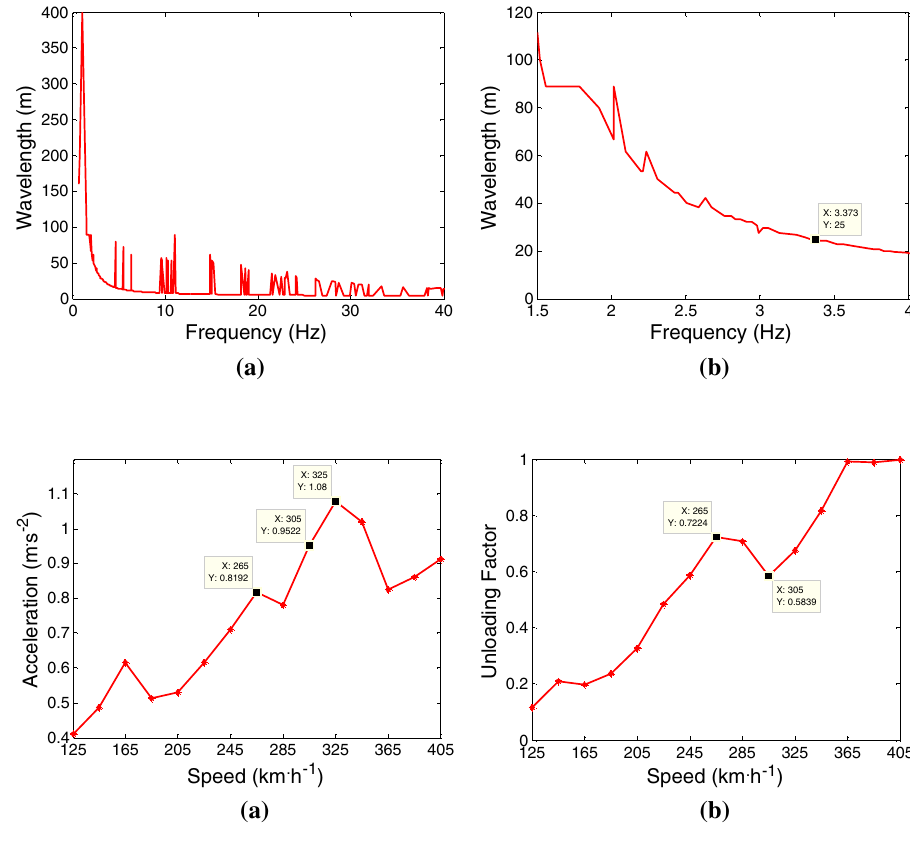
Fig. 12 Wavelengths of dominant mode shapes of the cantilever of the fourth span at the center of the track: a modal frequency 0–40 Hz and b modal frequency 1.5–4 Hz